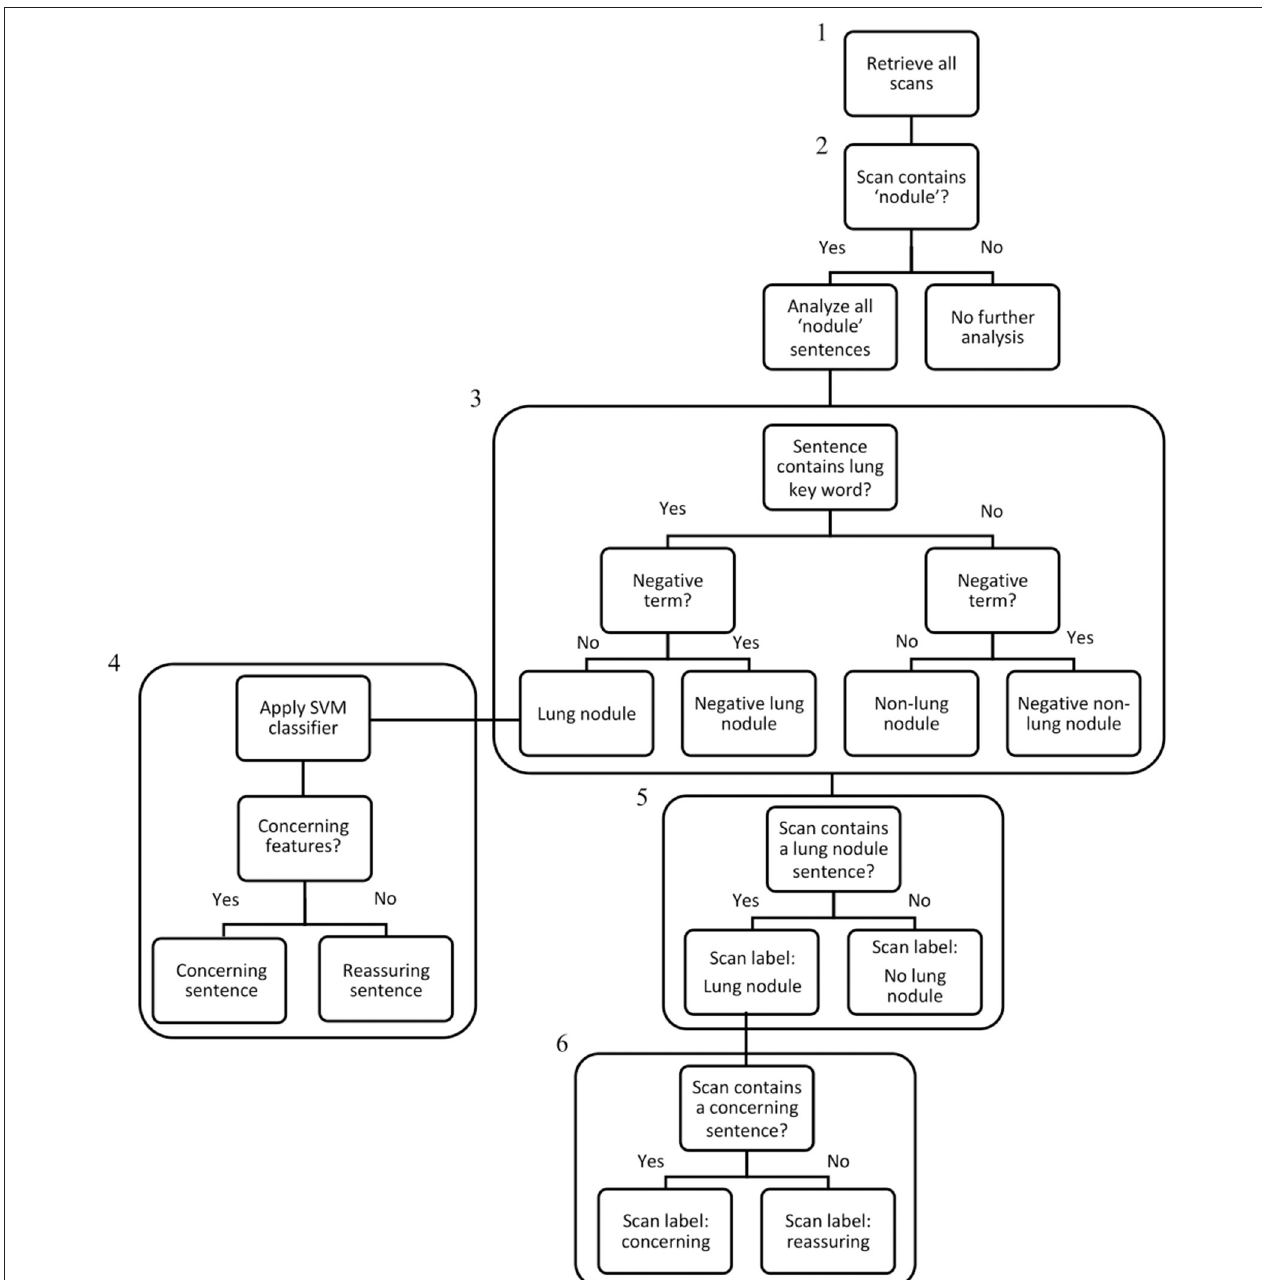
FIGURE 1 | Algorithm data processing flowchart. Step 1: All CT scan reports generated in the 10-year study period were extracted from the EHR system using an SQL search (242,996 scans – the “denominator” set). Step 2: The NLP algorithm searched all scan reports for the term “nodule,” and if present, selected the scans for analysis (79,534 scans). Step 3: All sentences within nodule scans were analysed and categorised individually and assigned a label: “Lung nodule,” “Negative Lung Nodule,” “Non-Lung Nodule,” “Negative Non-Lung Nodule”. Step 4: For sentences categorised as “Lung Nodule,” the linear-SVM classifier was used to assign a binary classification of “concerning” or “reassuring.” Step 5: If any sentence within a scan contained a “Lung Nodule” categorisation, the scan received a “Lung Nodule” label. Step 6: If any “Lung Nodule” scan contained a concerning sentence, the scan received a “concerning” label. As scans without any nodule terms were excluded at Step 2, the IDs of lung nodule patients were used to ensure all their scans from the denominator set (including scans without any nodules terms) were included in the final lung nodule dataset of 14,586 patients and 110,339 scans. All NLP code was developed using Python v3.8. The second algorithm step was to identify scans containing the word “nodule” using a search of the report text after converting to lower case and removing whitespaces and line breaks (79,534